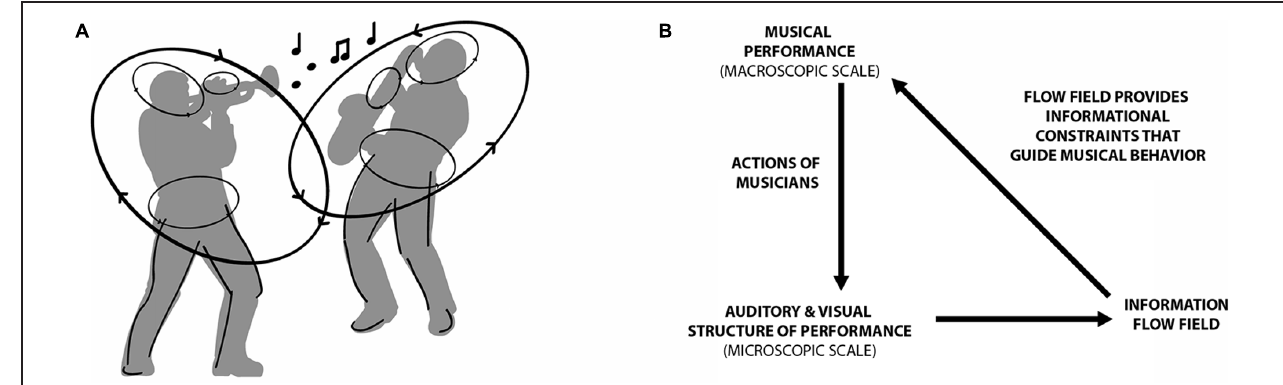
FIGURE 4 | Macroscopic and microscopic interaction involved in musical improvisation. (A) Structural changes in visual and auditory information about co-performers actions at both local and global levels serve to constrain musical produce. (B) Adapted from Kugler and Turvey (1987),